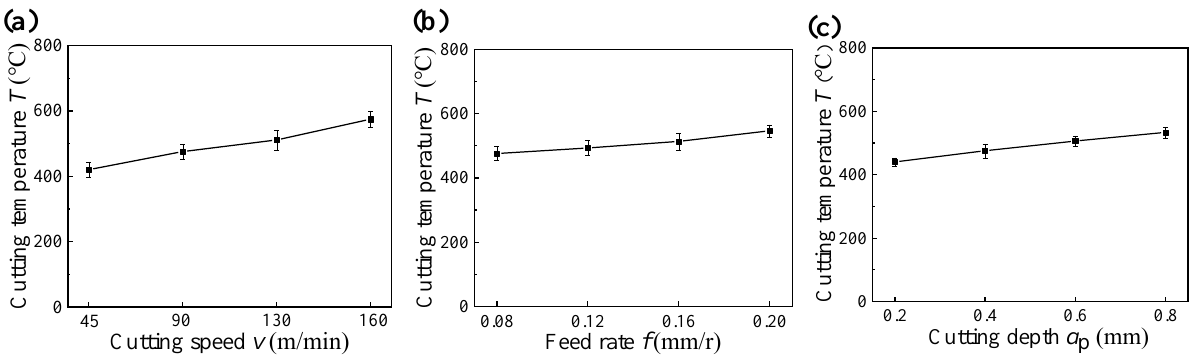
Figure 6. Microhardness of samples machined under different cutting parameters: ( a ) cutting speed, ( b ) feed rate, and ( c ) cutting depth.